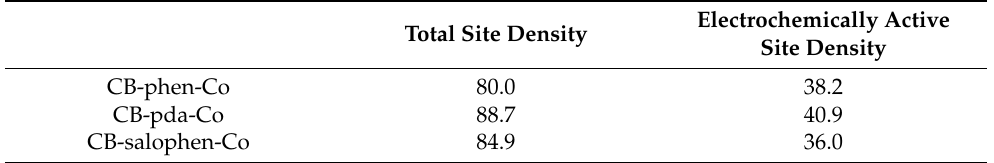
Table 2. Comparison of the total density of Co sites from ICP-MS analysis and electrochemically active Co sites from CV curves (unit: nmol · cm − 2